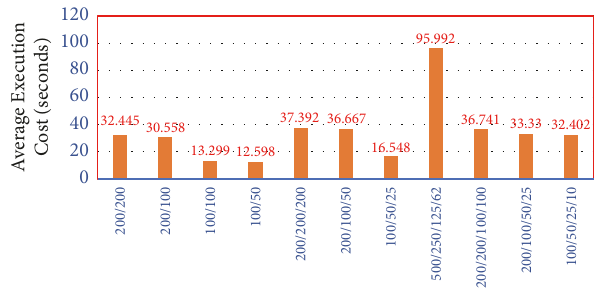
Figure 6: Effect of number of hidden layers and nodes in a DNN on average execution